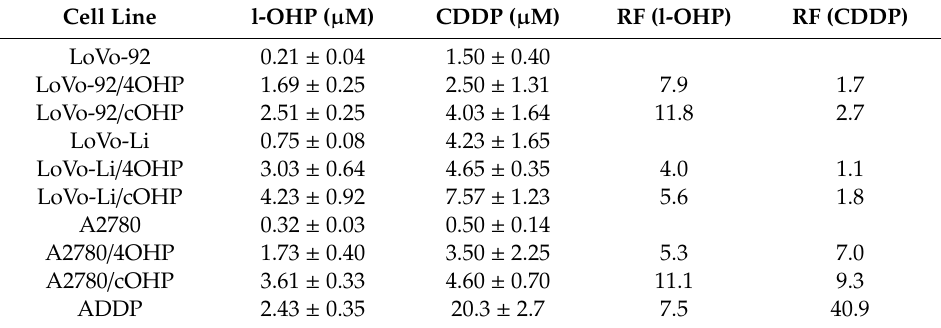
Table 1. Sensitivity to oxaliplatin and cisplatin in parental- and drug-resistant variants of colon and ovarian cancer cell